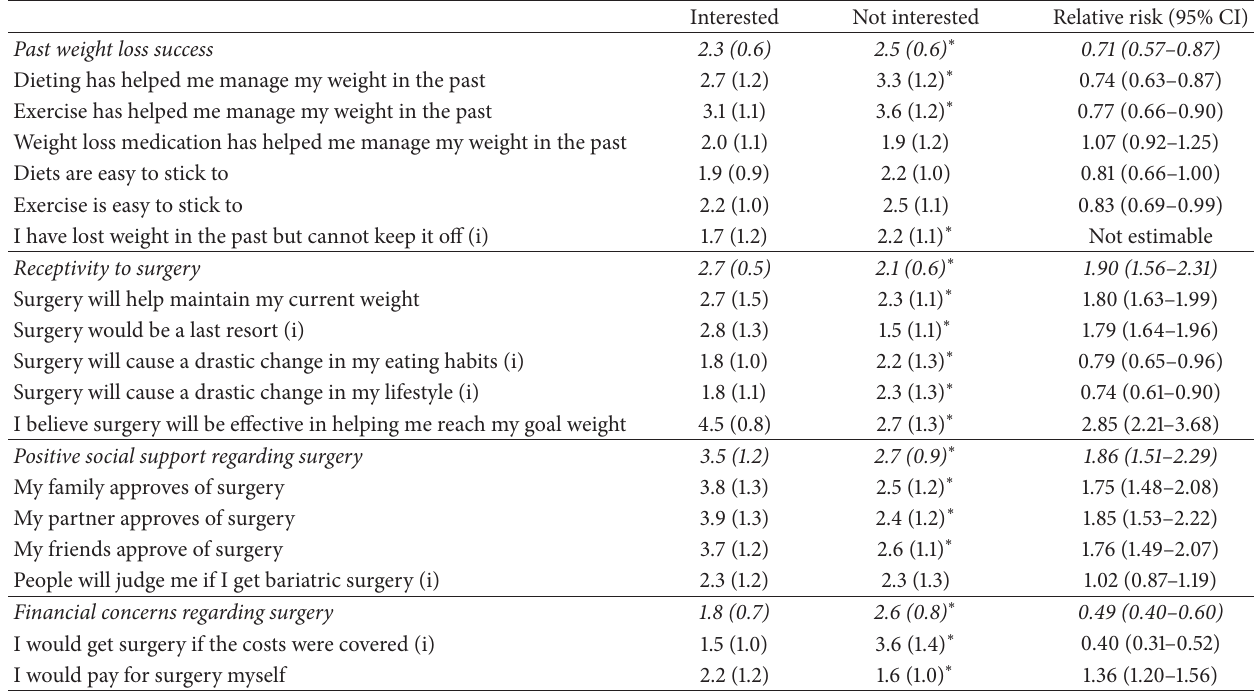
Table 3: Mean scores for responses to questions regarding receptivity to bariatric